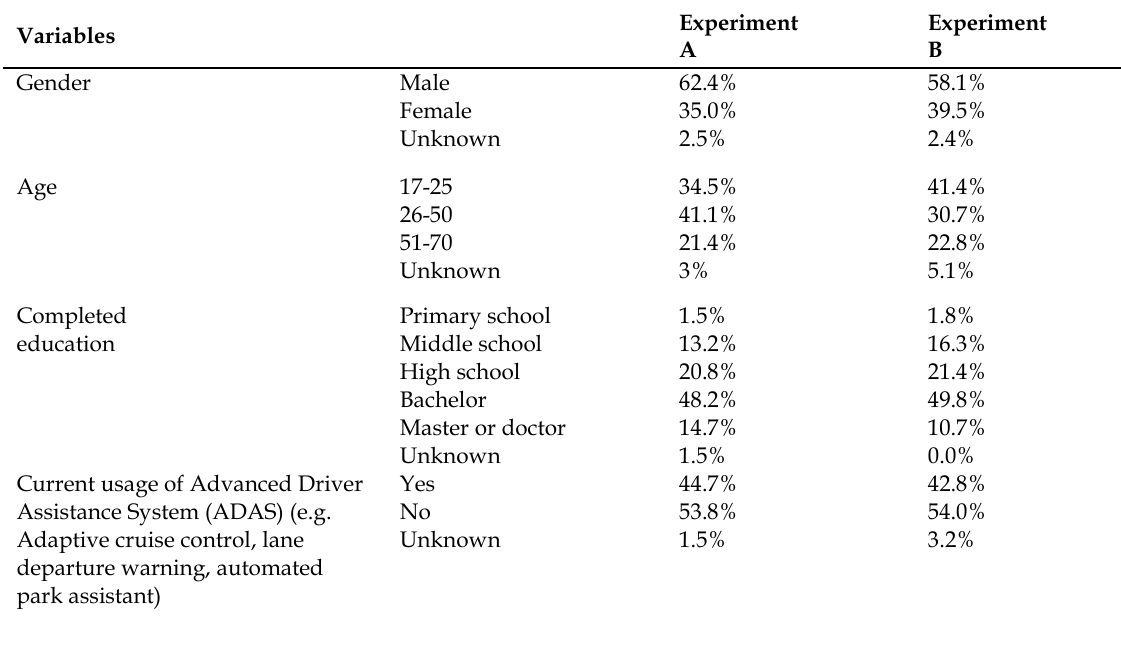
Socio-demographic and other relevant characteristics of the